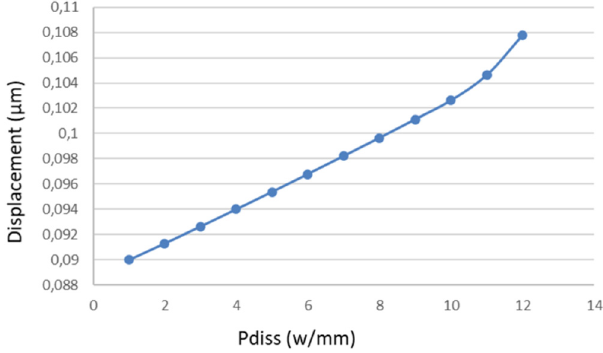
Fig. 5. Evolution of maximum displacements as a function of the power dissipated in the HEMT structure.